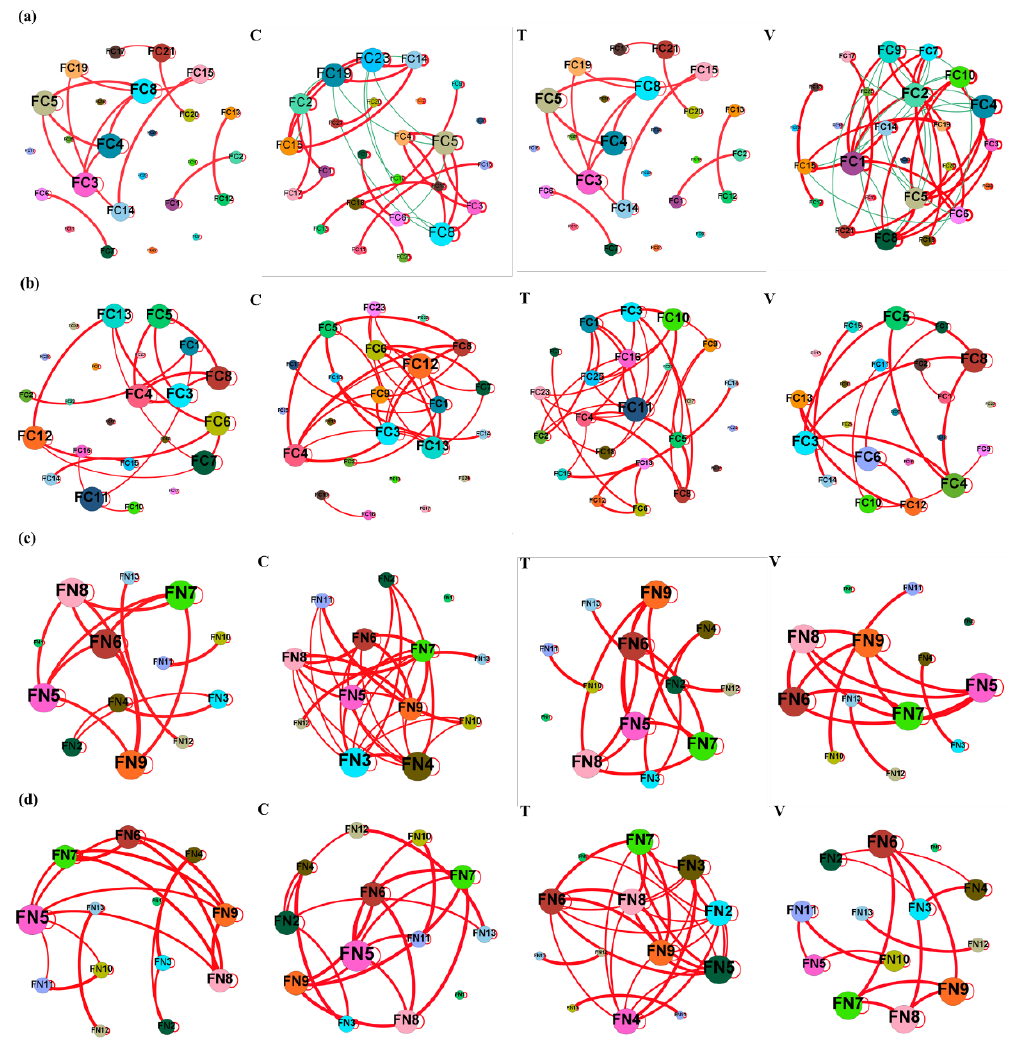
Figure 6. Co-occurrence network of bacterial functions related to the carbon and nitrogen cycle in water column and sediment. ( a ), Carbon cycle in water; ( b ), Carbon cycle in sediment; ( c ), Nitrogen cycle in water; ( d ), Nitrogen cycle in sediment. The size of each node indicates the connection degree of the bacterial function, and the color of each node indicates different functional taxa. Red lines represent positive correlations, and green lines represent negative correlations. The thickness represents the absolute value of the correlation coefficient.